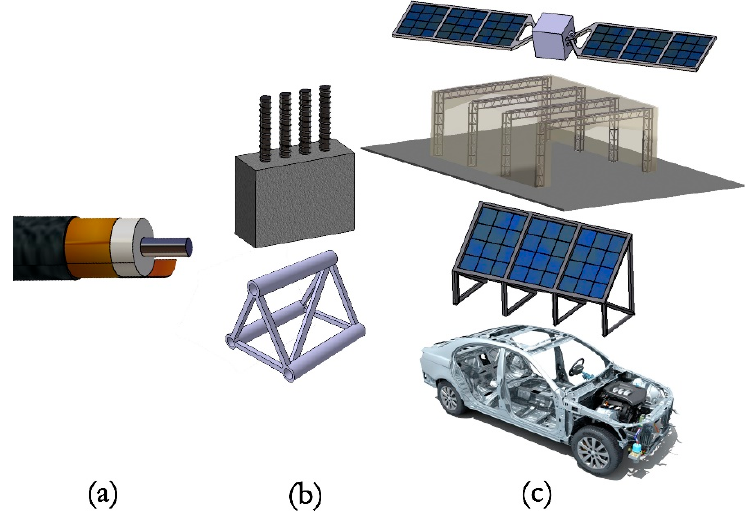
Figure 1. The coaxial all-solid-state battery and possible applications; ( a ) coaxial structural battery; ( b ) structural components: rebars, truss sets; ( c ) structures: vehicles, industrial equipment, solar panels, satellite arms, and antennas.